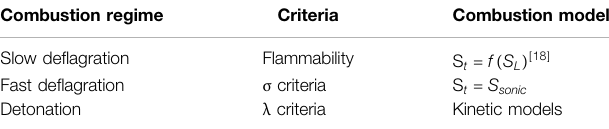
TABLE 1 | Structure of CREBCOM